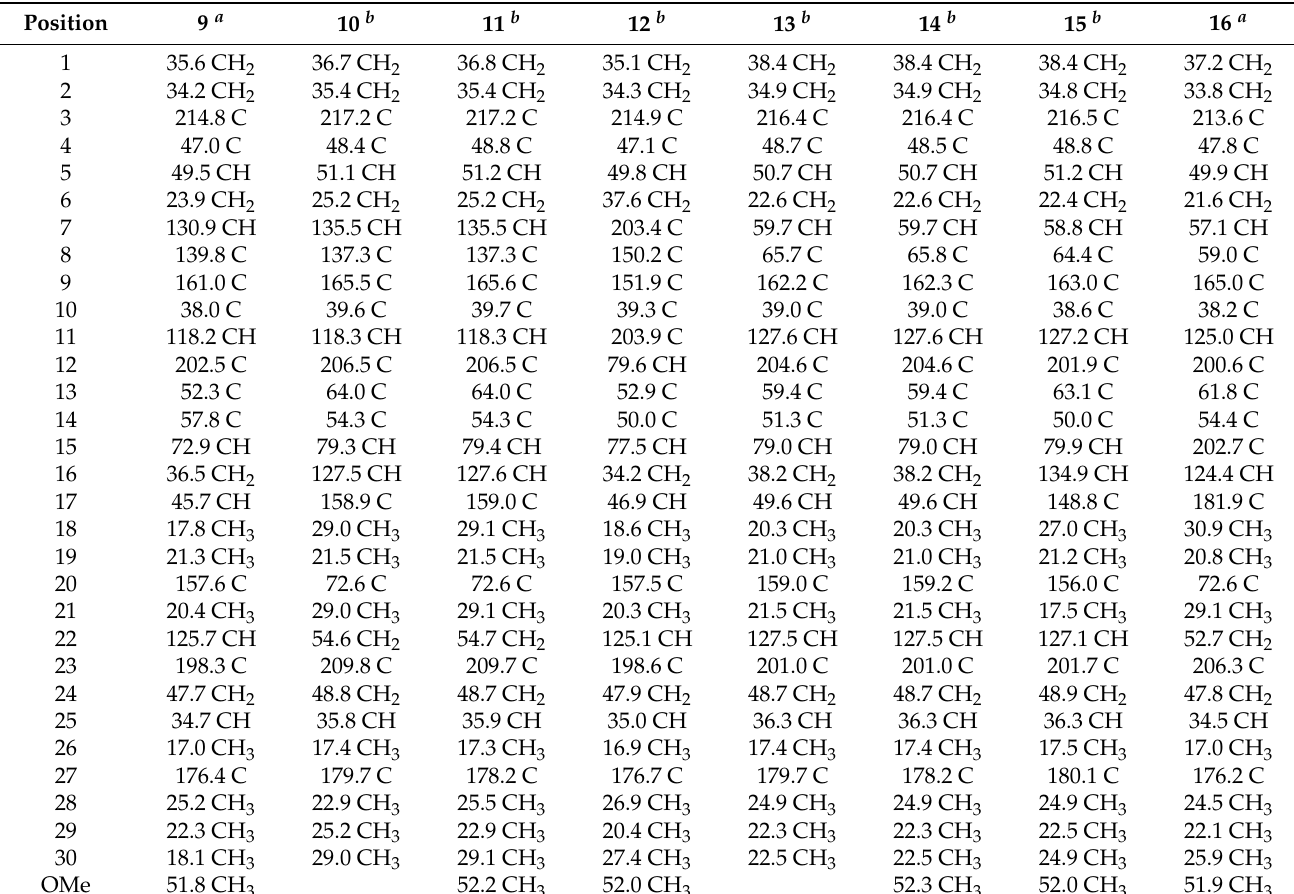
Table 4. 13 C NMR spectra of compounds 9 – 16 (150